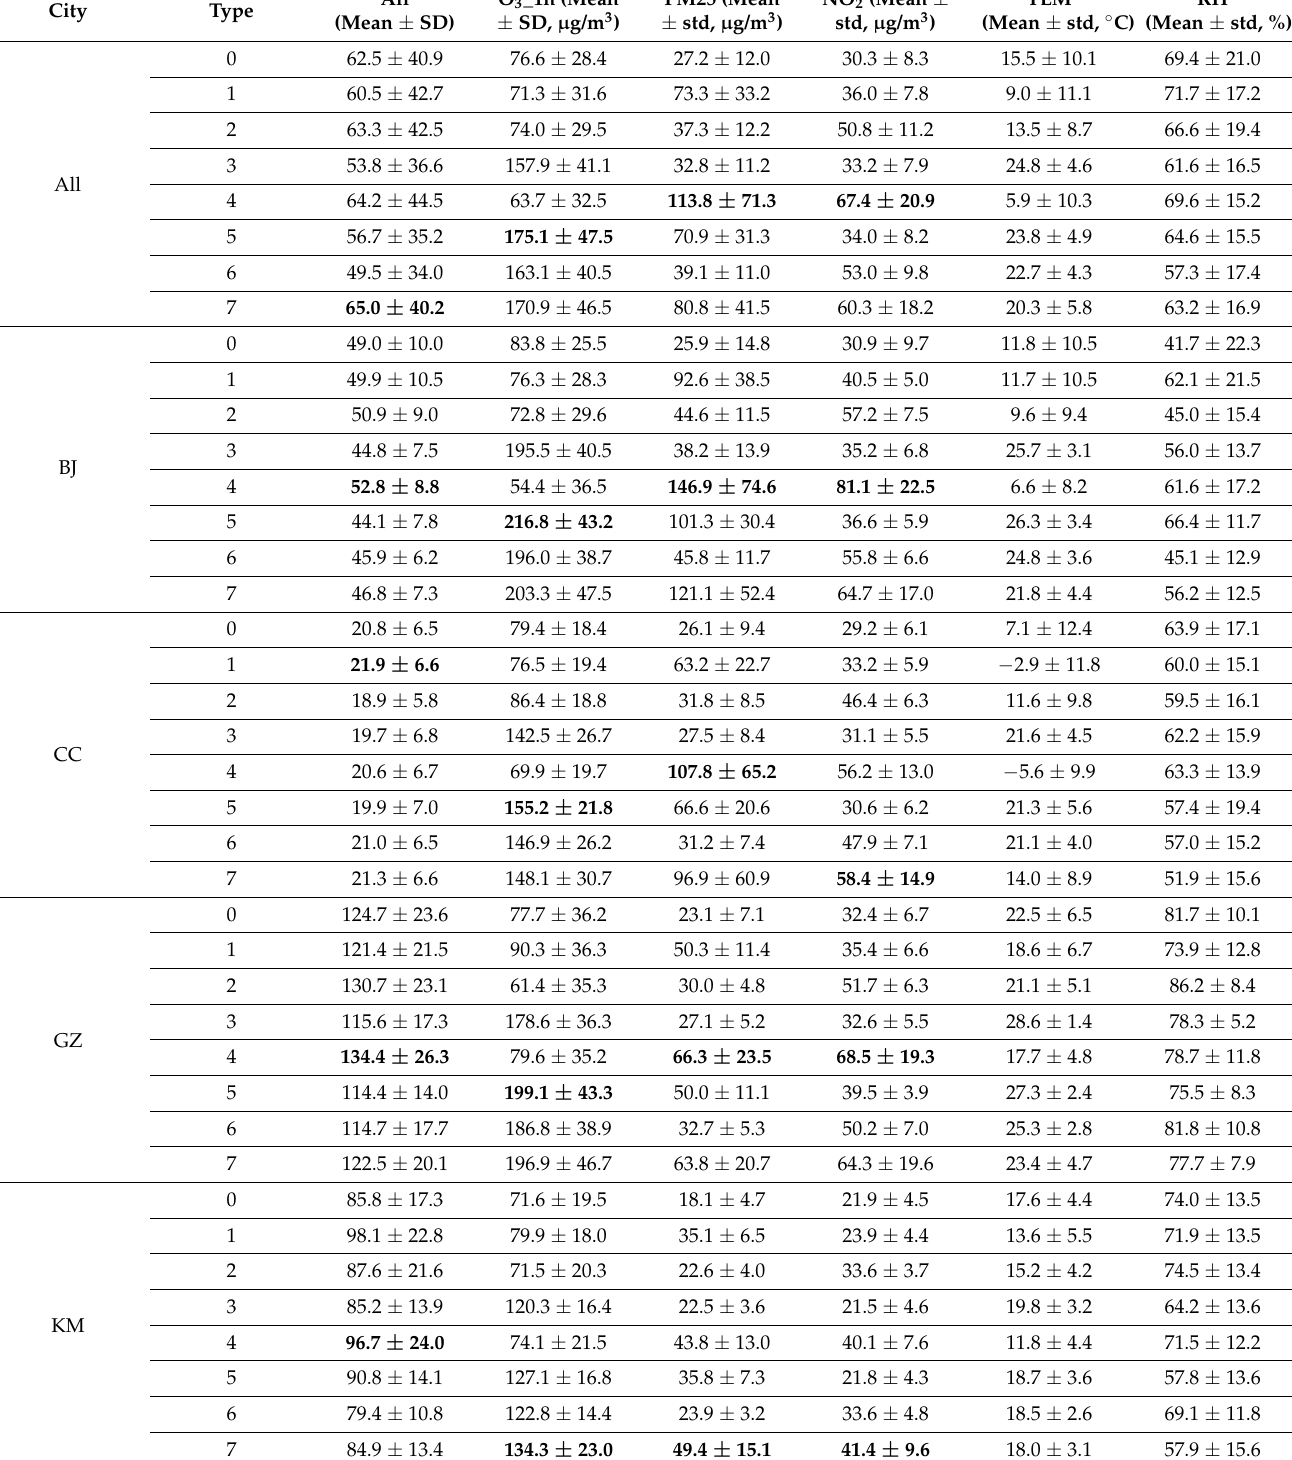
Table A1. Annual average of daily mean concentrations (standard deviation) for air pollution, meteorological variables, and daily all-cause mortality for each pollution type in 8 Chinese cities, 2013–2016. The bold represent the statistics of the pollution types with the highest all-cause deaths and pollutant concentrations in each